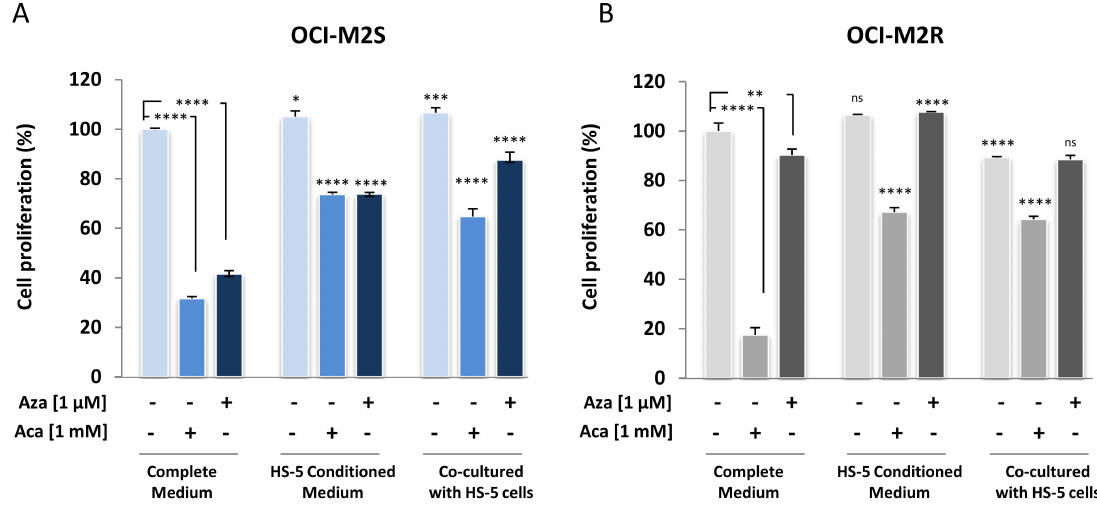
Figure 5. Aca fails to induce its antileukemic e ff ect in MDS / MSC co-culture experiments. ( A ) OCI-M2S cells were growth in complete, in HS-5 conditioned medium or co-cultured with HS-5 stromal cells. Cells were then treated with 1 mM Aca or 1 µ M Aza. 48 h later, loss of cell proliferation was assessed using the XTT assay as described in Figure 1. Each assay was performed in quadruplicate. ( B ) OCI-M2R cells were growth in complete, in HS-5 conditioned medium or co-cultured with HS-5 cells. Cells were then treated with 1 mM Aca or 1 µ M Aza. 48 h later, loss of cell proliferation was assessed using the XTT assay as described in Figure 1. Each assay was performed in quadruplicate. Statistical analyzes of histograms for “HS-5 Conditioned Medium” and “Co-cultured with HS-5” conditions are compared to the “Complete Medium” used as control. * p < 0.05, ** p < 0.01, *** p < 0.001, **** p < 0.0001, ns: not